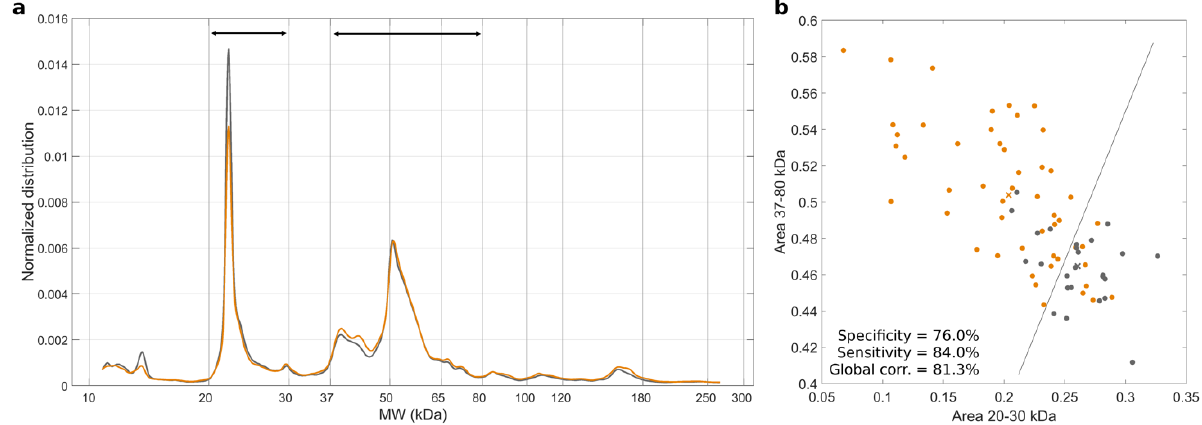
Figure 1. ( a ) Exposing graphene oxide (GO) nanosheets to human plasma (HP) from PDAC patients and healthy volunteers leads to the formation of personalized protein coronas. Protein patterns were isolated from GO and analyzed by 1-dimensional (1D) SDS-PAGE. ( a ) Average molecular weight (MW) distributions of N = 50 PDAC patients (orange solid line) and N = 25 healthy volunteers (black solid line) were obtained by the individual profiles reported in Figure S4 in the SM. ( b ) Scatter plots of the integral areas show the largest difference between the 1D SDS-PAGE profiles (i.e., those between 20 and 30 KDa, and between 37 and 80 kDa). Each point refers to a single human subject (orange for PDAC and black for healthy participants in the study), while the crosses indicate the centers of the two distributions. The solid black line depicts the output of the linear discriminant analysis for the two distributions. The corresponding receiver operating characteristic (ROC) curve is reported in Figure 2.